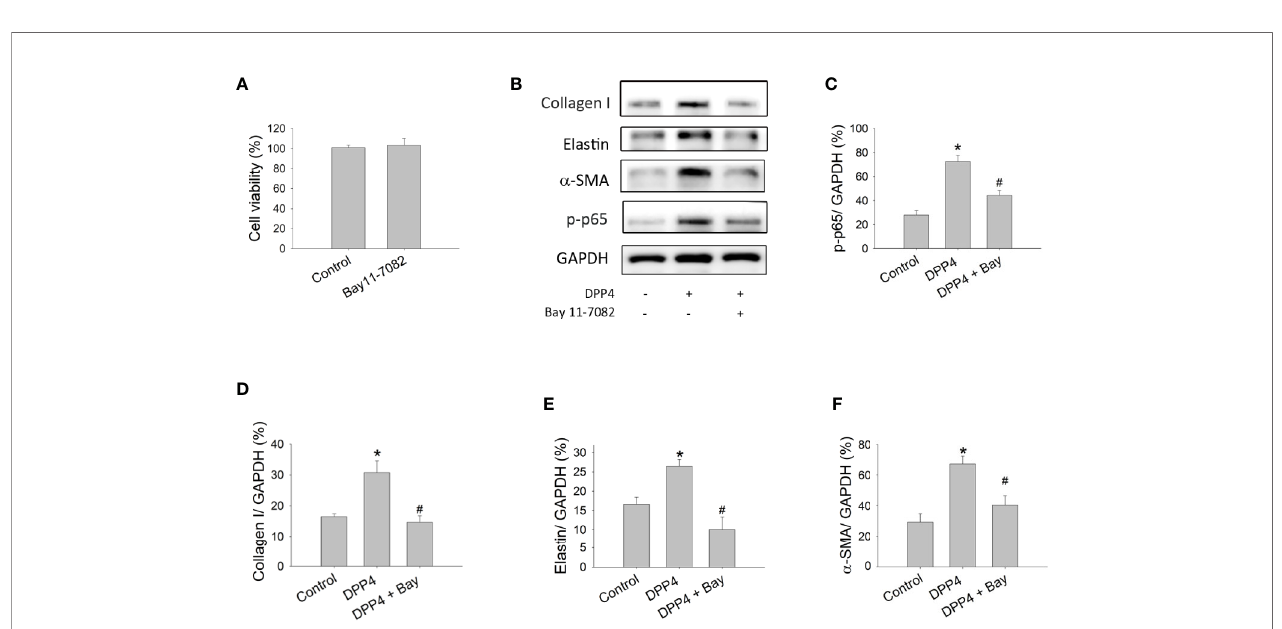
FIGURE 3 | Effects of NF- k B inhibition on the activation of fi broblasts. Cell viability and protein expression were measured in NIH-3T3 fi broblasts after their treatment with recombinant DPP4 (200 ng/ml) in the presence or absence of Bay11-7082 (1 µM), a NF- k B inhibitor. (A) Cell viability of fi broblasts exposed to Bay11-7082. (B) Protein expression determined using Western blotting. Calculated ratios of (C) p-p65 to GAPDH, (D) collagen I to GAPDH, (E) elastin to GAPDH, and (F) a -SMA to GAPDH were shown. (n=4) * p <0.05 vs. control. # p <0.05 vs. DPP4.